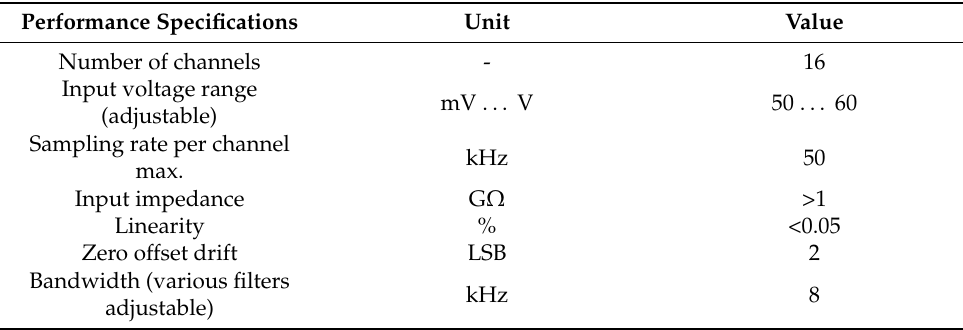
Table 4. Basic technical data of the µ EEP-12 data acquisition system